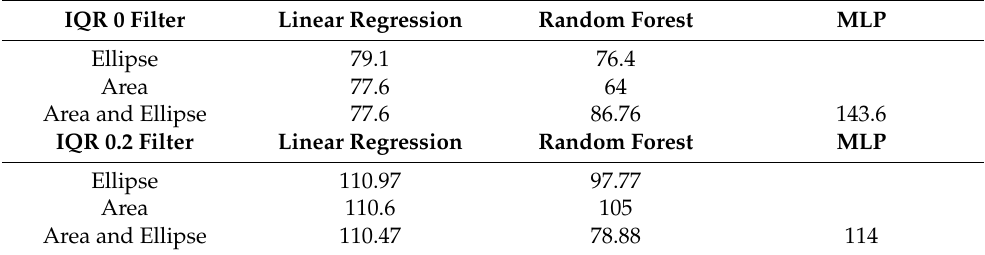
Table 1. The accuracy of the